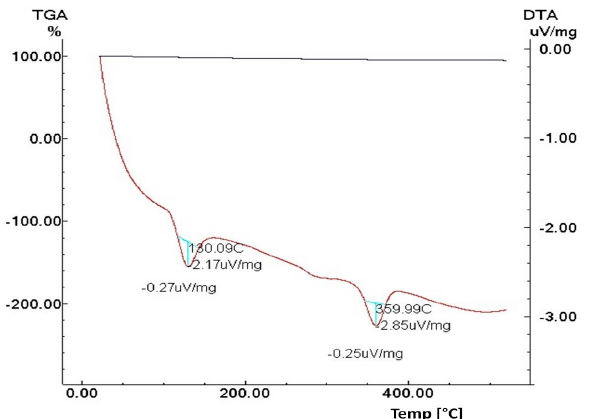
Figure 3. Thermal analysis, DTA (brown trace) and TGA (black trace), of zinc ferrite.